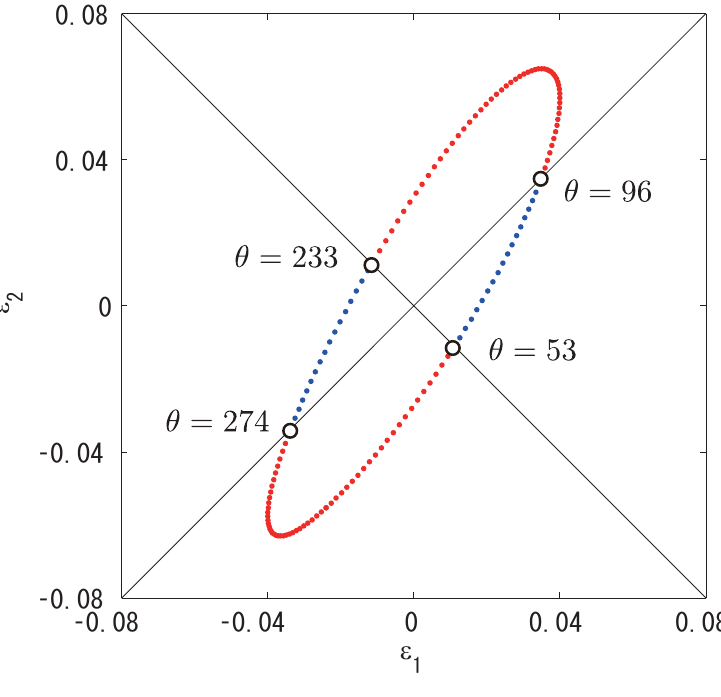
Figure 5. Relationship between (cid:15) is more robust than algorithm-2, are indicated by the red dotted lines. The values of θ are shown at the boundaries of the